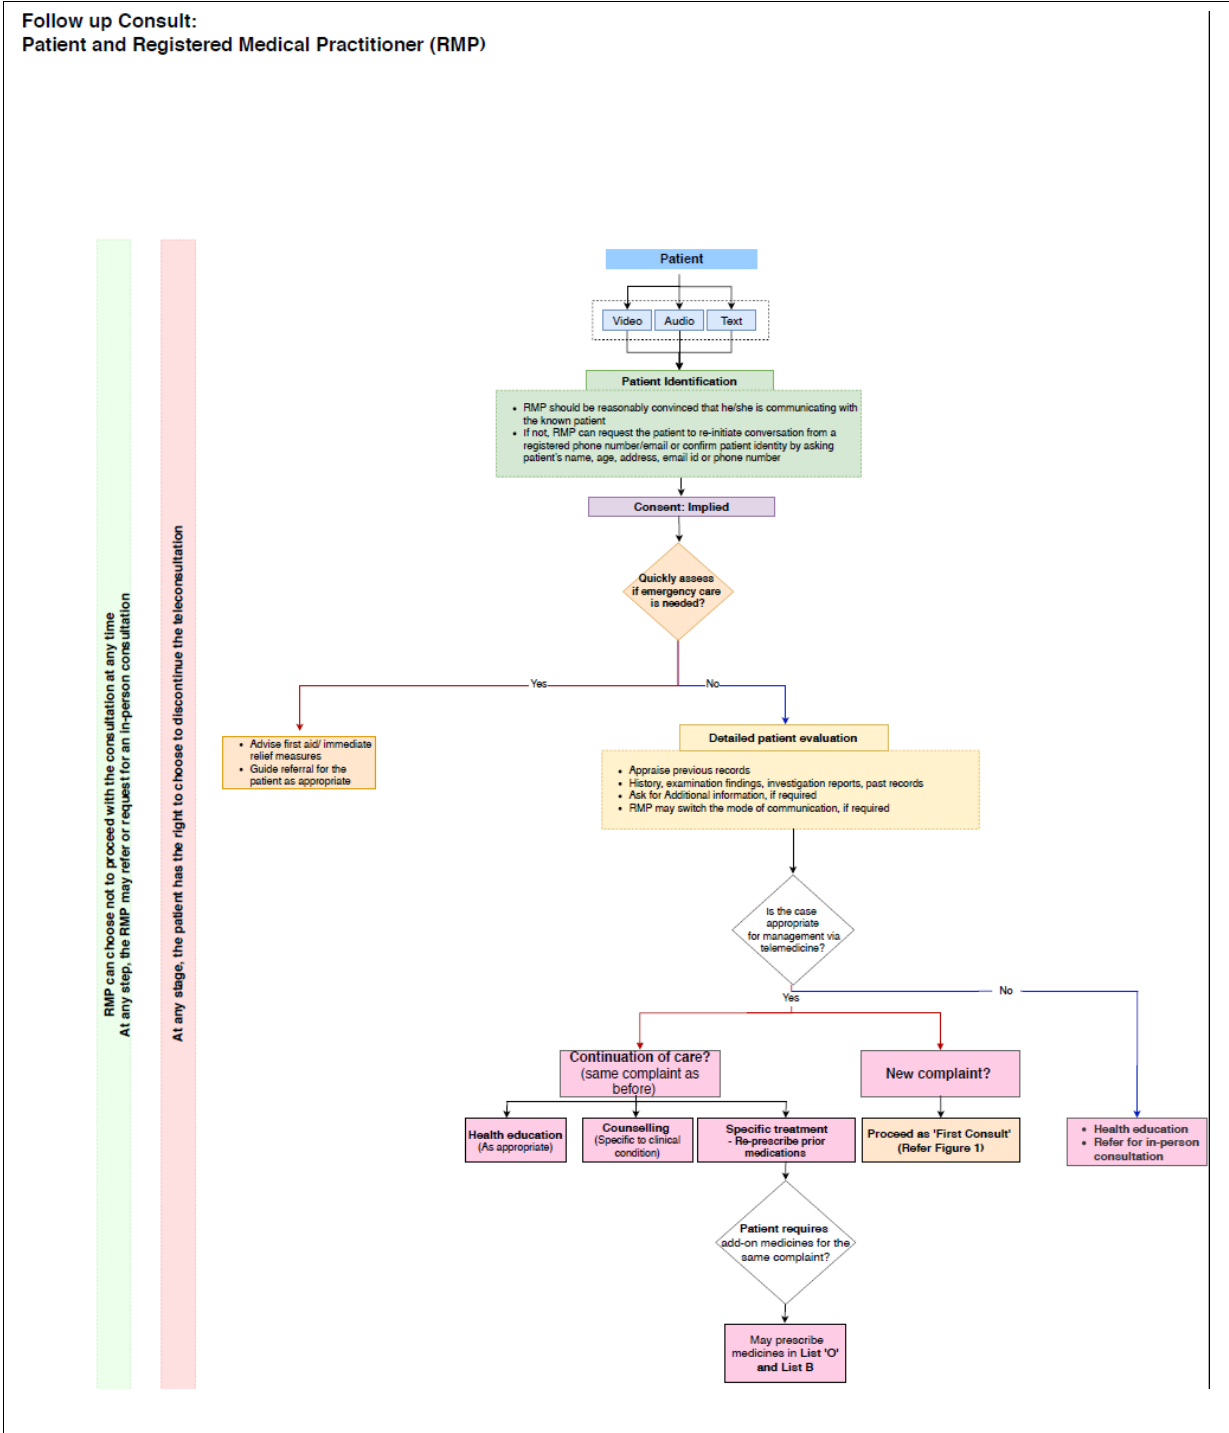
Figure 2: Flow Chart for teleconsultation on follow-up